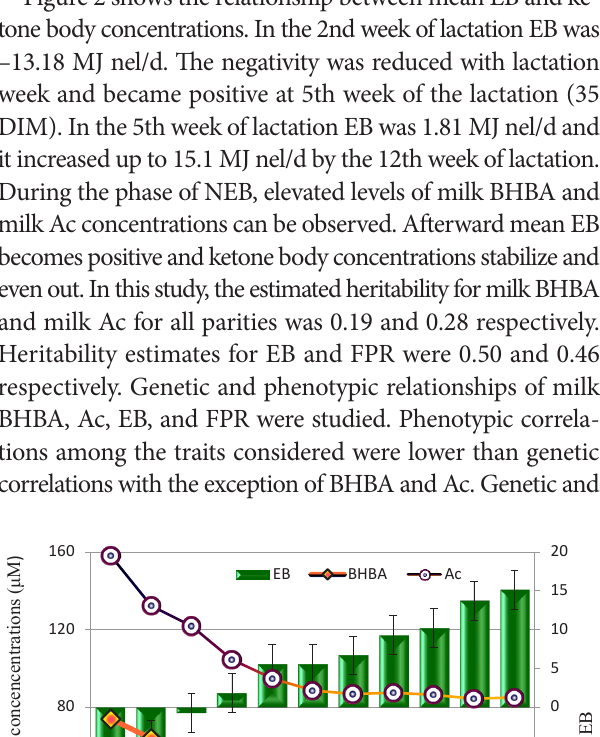
Table 1. Descriptive statistics for the traits including milk β -hydroxybutyrate (BHBA) and acetone Traits